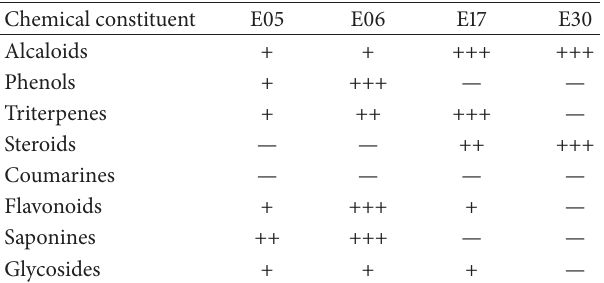
Table 9: Chemical composition of active extracts E05, E06, E17, and